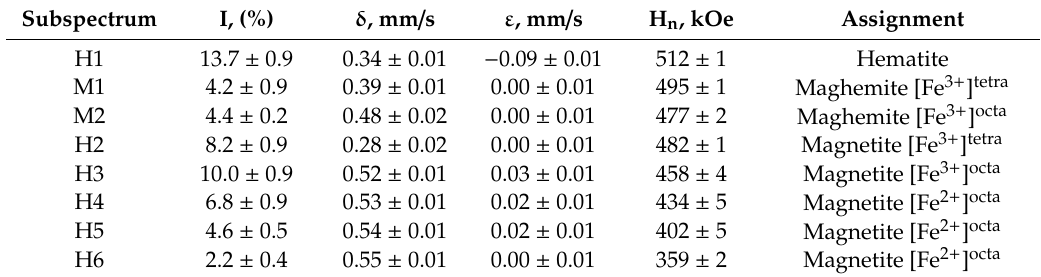
Table 2. Hyperfine parameters of the magnetic fraction obtained from the MS spectrum of the fly ash